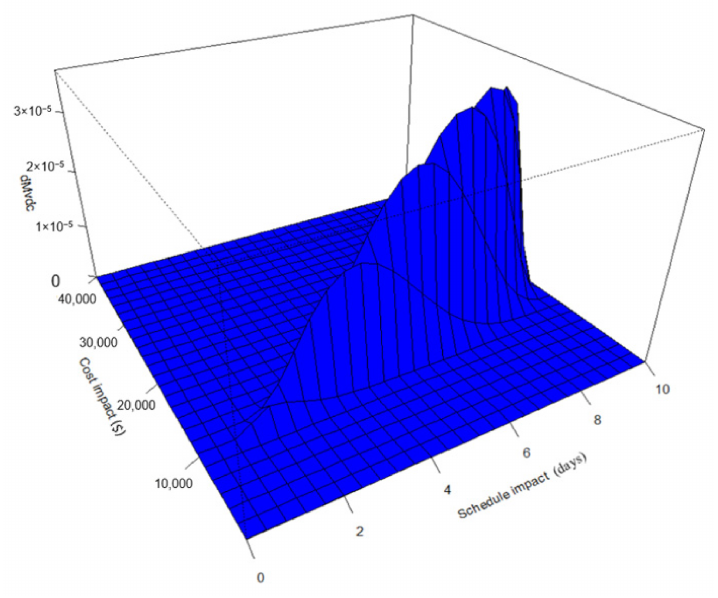
Figure 13. Dependence structure between cost and schedule-risk impact.